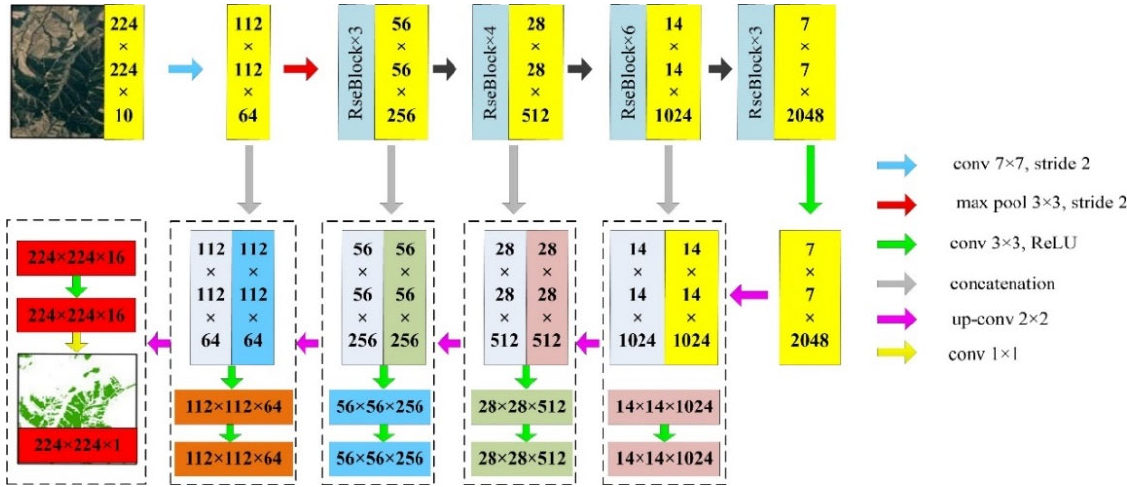
Figure 10. Adapted implementation of Mobile ‐ UNet architecture.